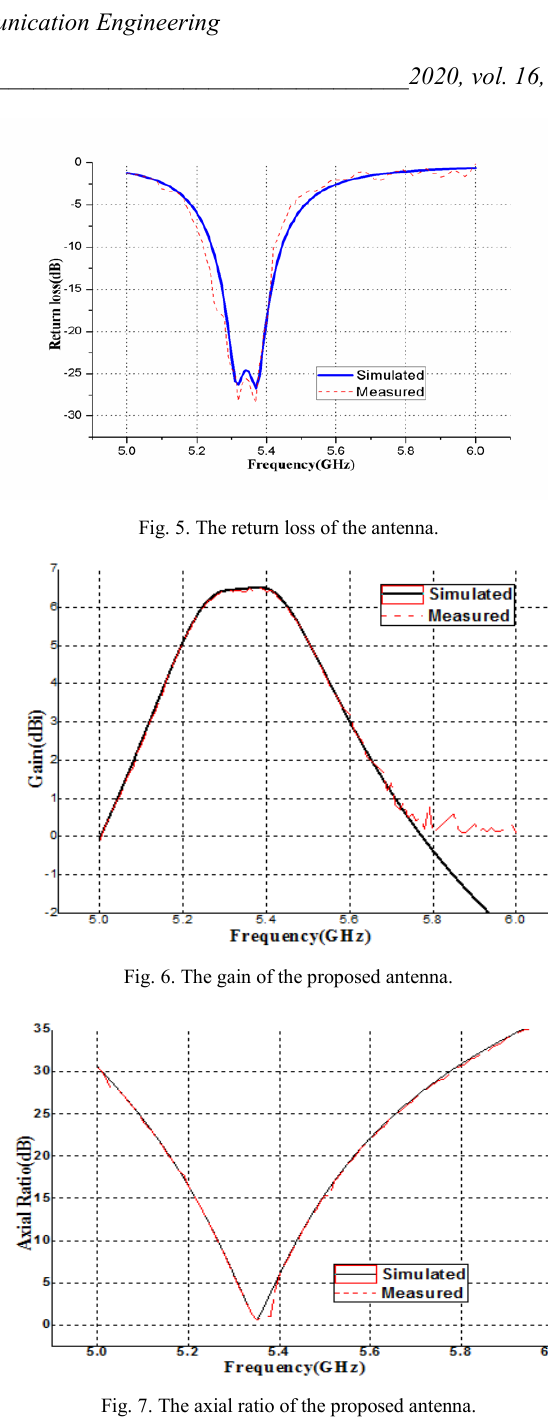
Fig. 7. The axial ratio of the proposed antenna.